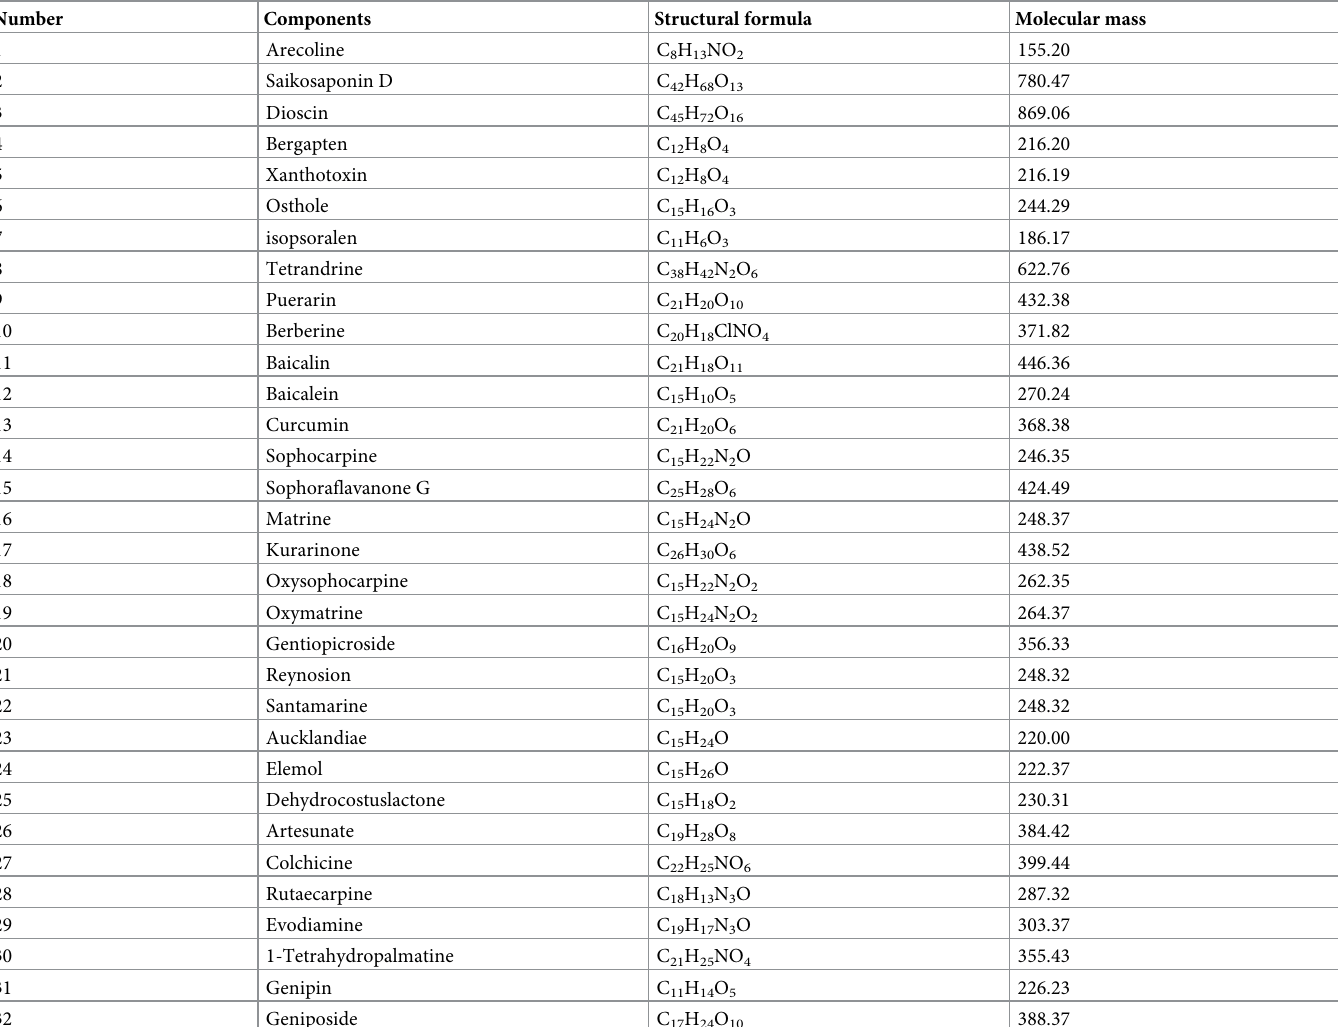
Table 1. The details about the components with liver injury from urate-lowering Chinese herbs.